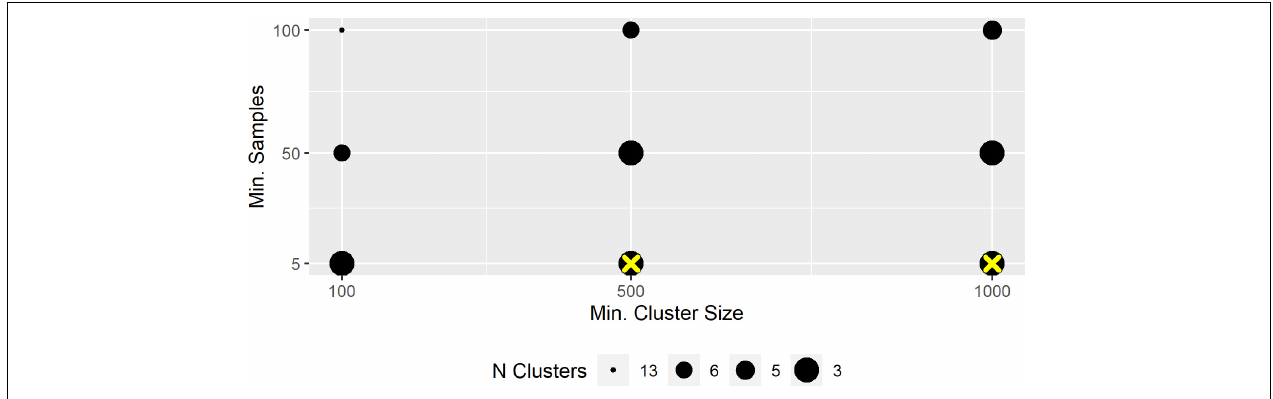
FIGURE 4 | Number of segregated macro-habitats. The Figure was produced with Epsilon = 0.32. Yellow cross: selected segregation.